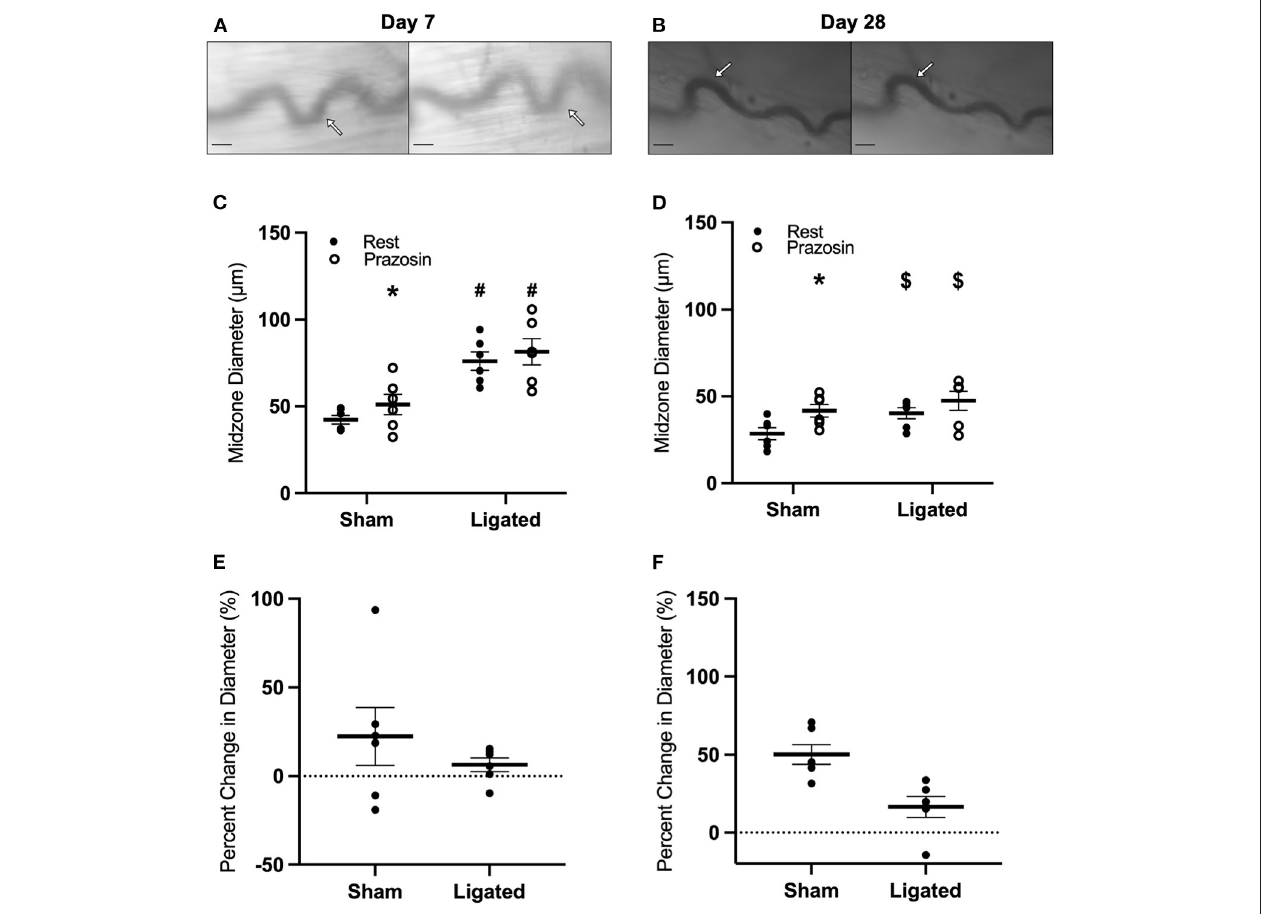
FIGURE 6 | Collateral vessels are insensitive to α -adrenergic inhibition at day 7 and 28. Collateral vessels were observed at the collateral midzone by intravital microscopy with transillumination at 7 days (A) or 28 days (B) post-femoral artery ligation in the left mouse hindlimb at rest (left) and following exposure to 10 − 4 M of α -1-adrenergic antagonist prazosin (right); arrows indicate the enlarged collateral arteriole and scale bar represents 100 µ m. α -adrenergic stimulation vasodilates native, but not enlarged collaterals at both day 7 ( C,E , n = 6) and day 28 ( D,F , n = 6). * p < 0.05 vs. resting, # p < 0.05 vs. sham, $ p < 0.05 vs. day